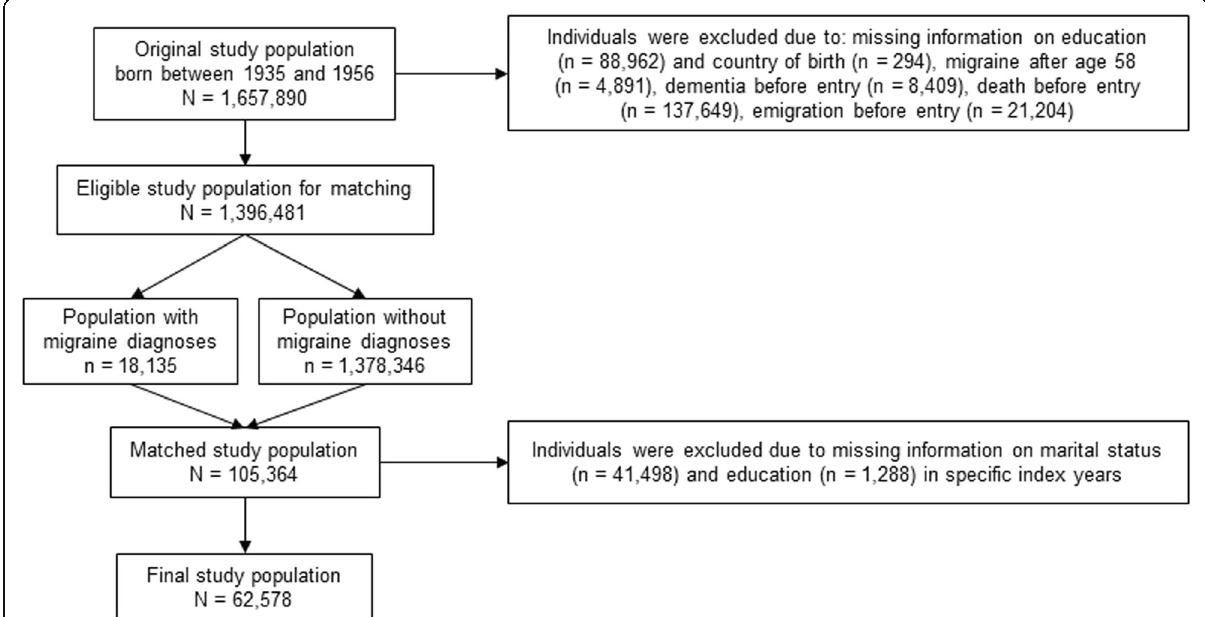
Fig. 2 Flow chart of the study population selected for analyses ( N = 62,578). Data were obtained on 1,657,890 inhabitants in Denmark born between 1935 and 1956. After excluding individuals due to missing information, migraine after age 58, or dementia, death or emigration before entry, 18,135 individuals with migraine diagnoses were matched with 1,378,346 individuals without migraine diagnoses. The matched study population consisted of 105,364 individuals, but also included individuals without information on education and marital status for specific index years and these individuals were therefore excluded after matching leaving 62,578 individuals eligible for